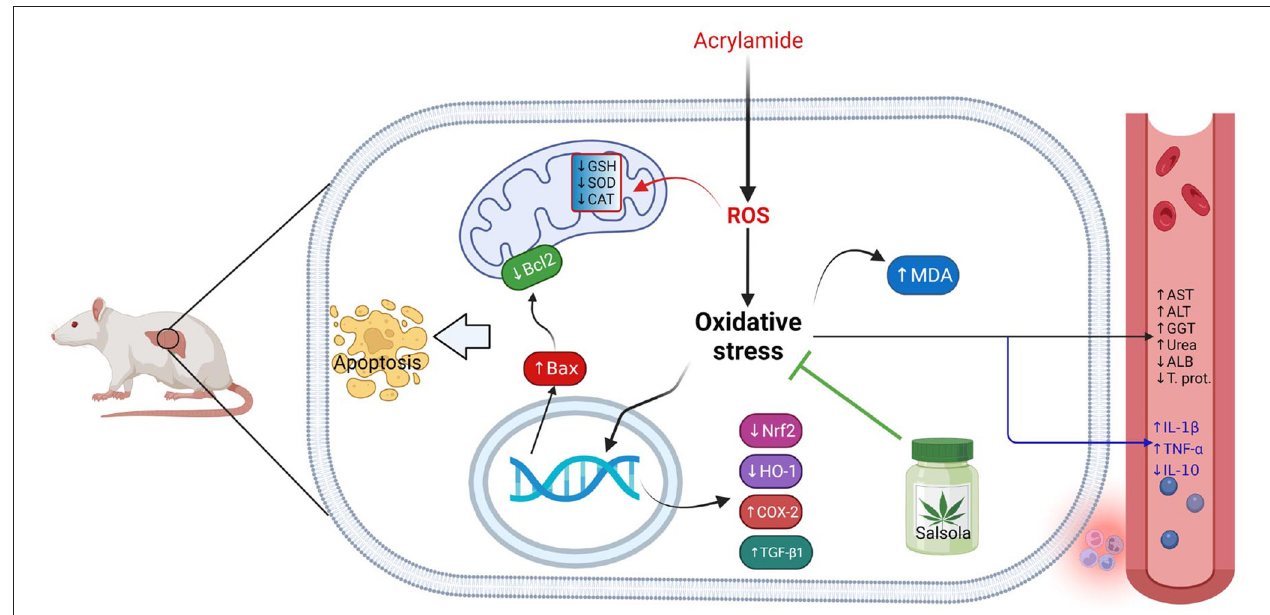
FIGURE 10 | Graphical abstract represents the hepatoprotective impact of Salsola imbricata extract on acrylamide-induced inflammation, oxidative stress, and liver